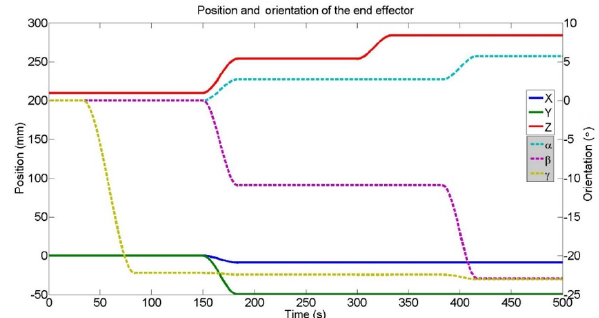
Figure 13. Evolution of the end effector coordinated during the simulated bone reduction